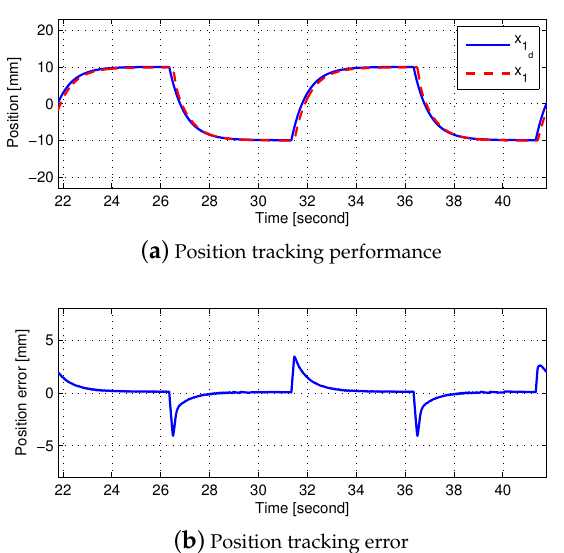
Figure 6. Experimental setup of the EHS system.